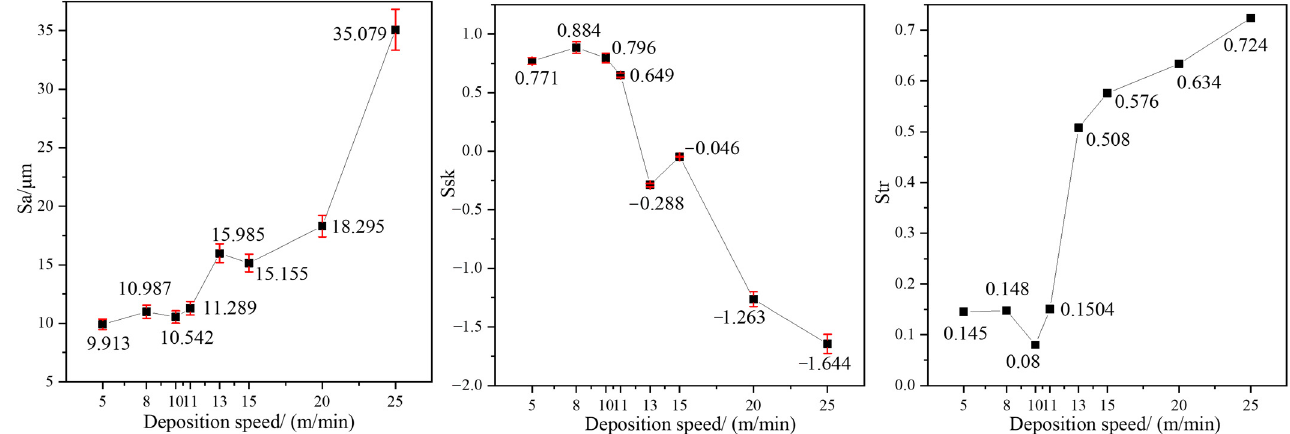
Figure 17. Variations of S a , S sk , and S tr with deposition speeds.